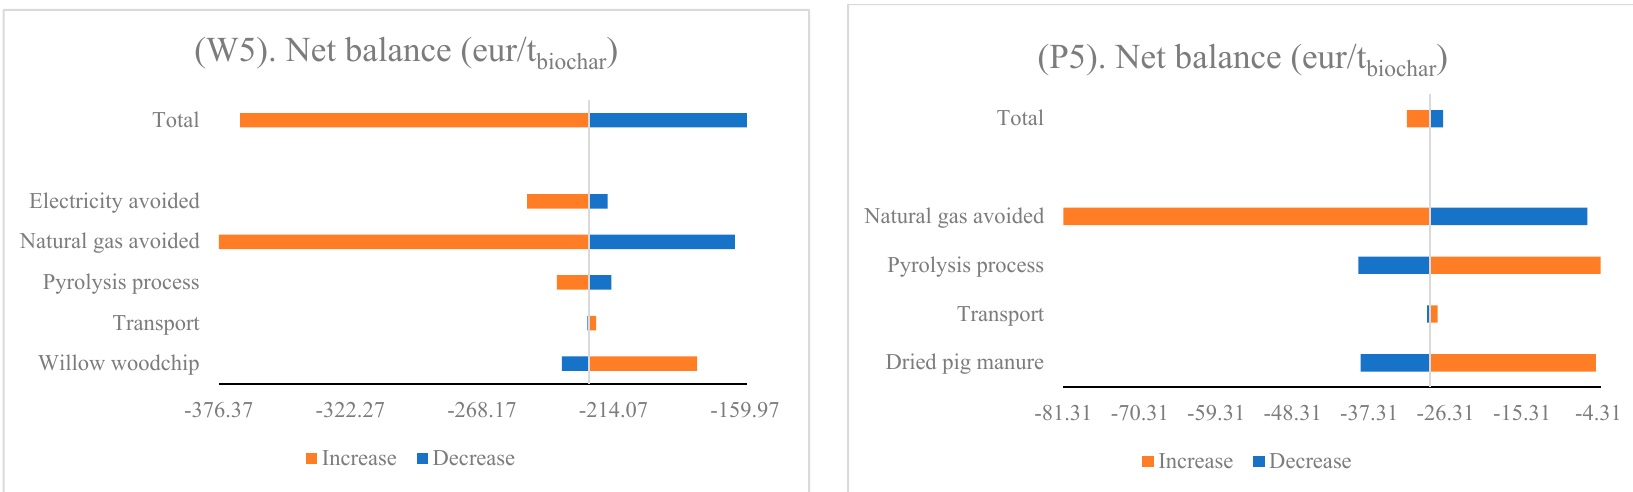
Figure 5. Sensitivity analysis of byproducts and NPK savings for each impact category-based environmental value for willow ( W1 – W5 ) and pig manure ( P1 – P5 ) biochar. (Note: vertical lines in the middle of the graph show the average environmental value of impact categories. Deviations from the average value show the changes in average environmental values by a 10% decrease or 10% increase in the average byproduct and NPK saving quantities).